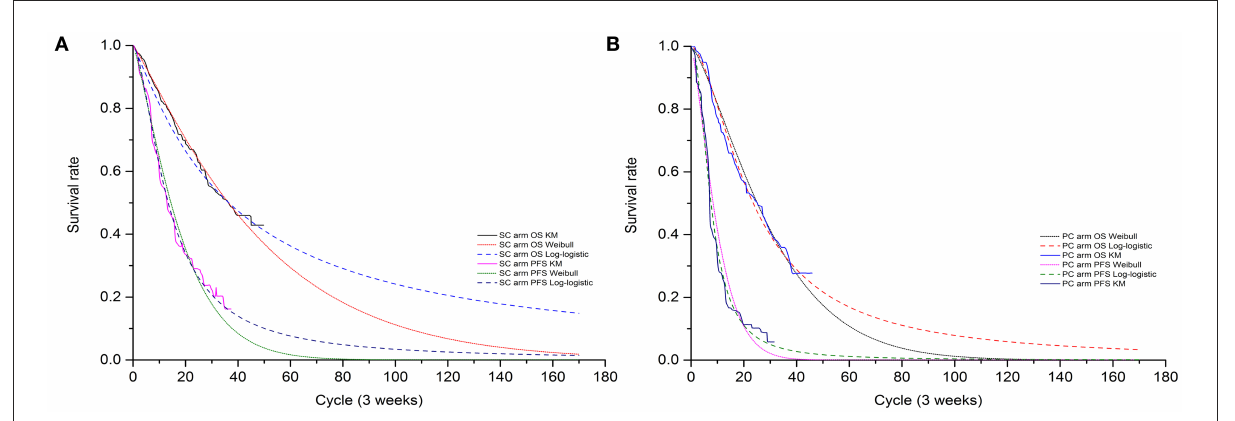
FIGURE2 The exploration and fitting of PFS and OS curves in SC arm (A) and in PC arm (B)